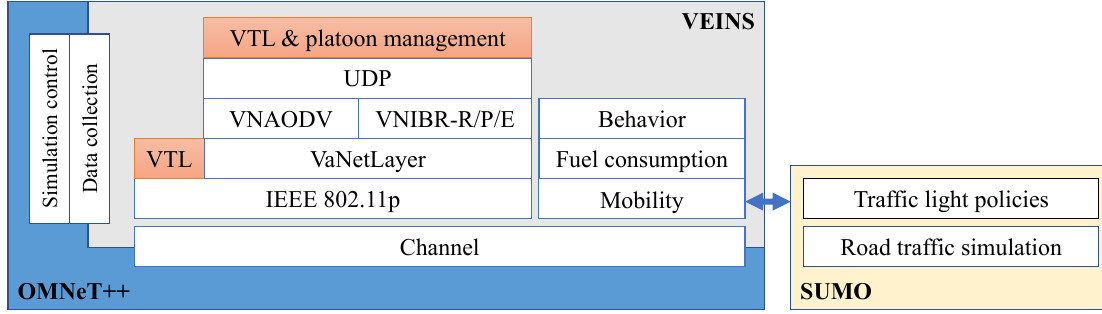
Figure 6. Architecture of our VEINS-based